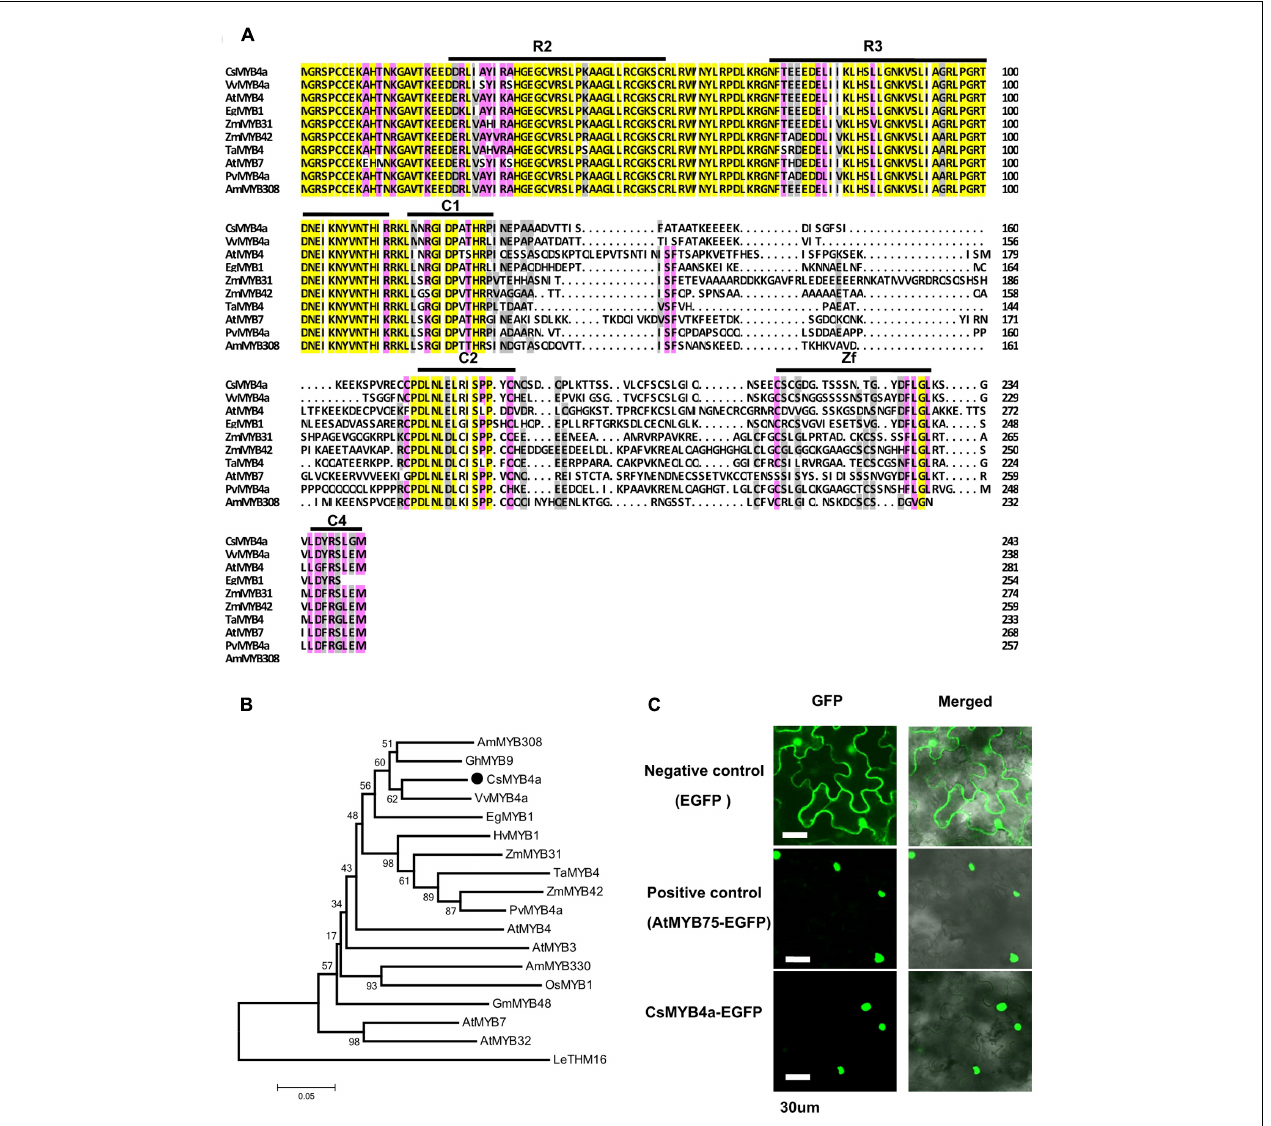
FIGURE 1 | Amino acid sequence alignment and phylogenetic analysis of CsMYB4a. (A) Amino acid sequence alignment utilized CsMYB4a and 10 other R2R3 MYB4 subgroup members. Black boxes and red boxes highlight the R2R3 domains and the potential regulatory domains, respectively. (B) A phylogenetic tree resulting from MEGA analysis using amino acid sequences of CsMYB4a and 18 other R2R3 MYB4 subgroup members. Accession numbers for MYB4-sugroup sequences: VvMYB4a (NP_001268129.1), EgMYB1 (CAE09058), AmMYB308 (JQ0960), ZmMYB31 (CAJ42202), ZmMYB42 (CAJ42204), TaMYB4 (AAT37167), PvMYB4a (JF299185), AtMYB4 (AY519615), AtMYB7 (AEC06531), AtMYB32 (NP_195225), AtMYB3 (NP_564176), AmMYB330 (P81395), GhMYB9 (AAK19619), GmMYB48 (ABH02823), OsMYB1 (BAA23337) and HvMYB1 (P20026). (C) Images obtained using confocal microscopy indicated nuclear localization of the